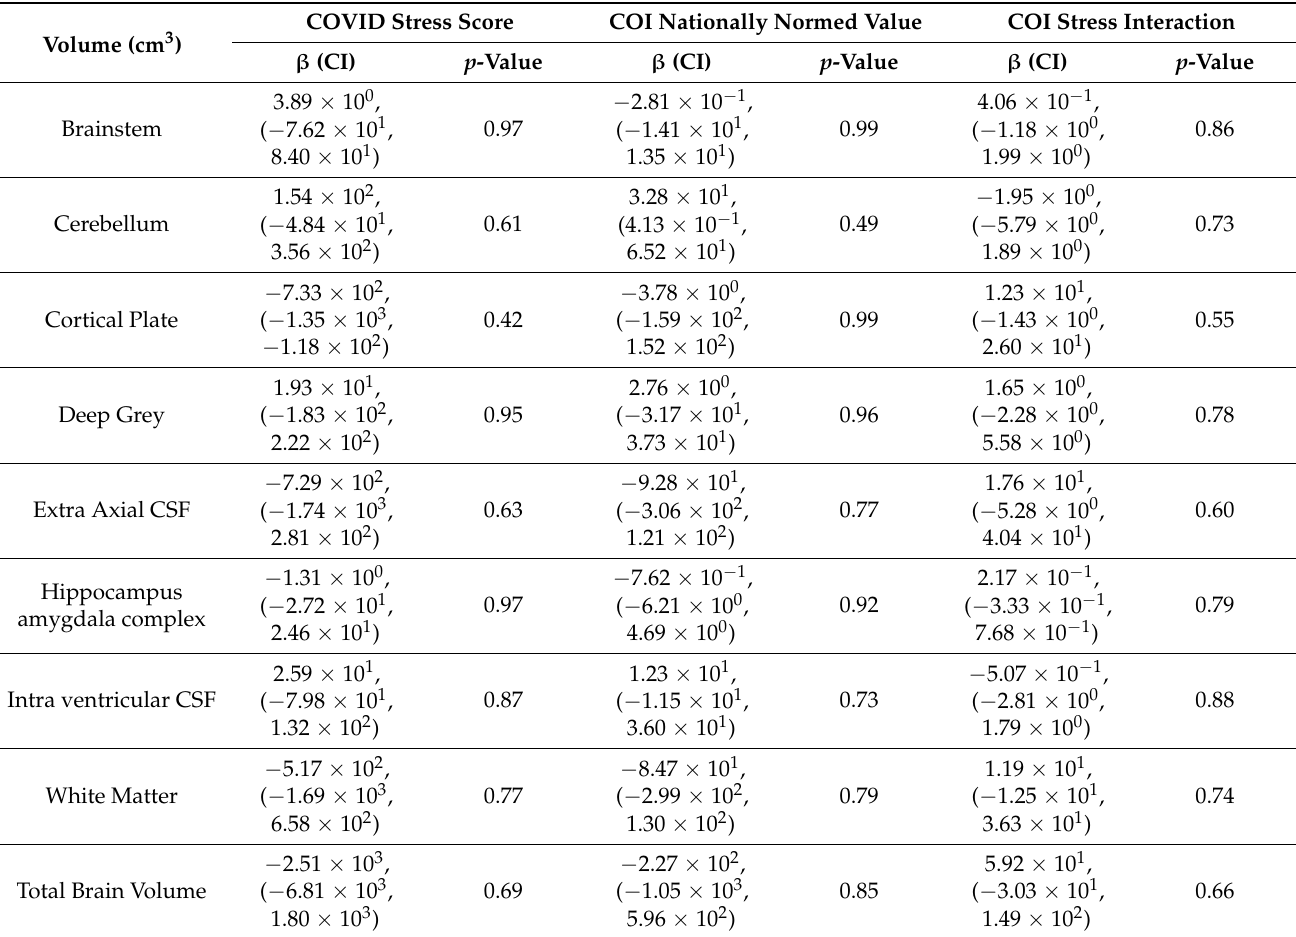
Table 2. Raw brain structure volumes relationship to COVID stress and COI-SEE.